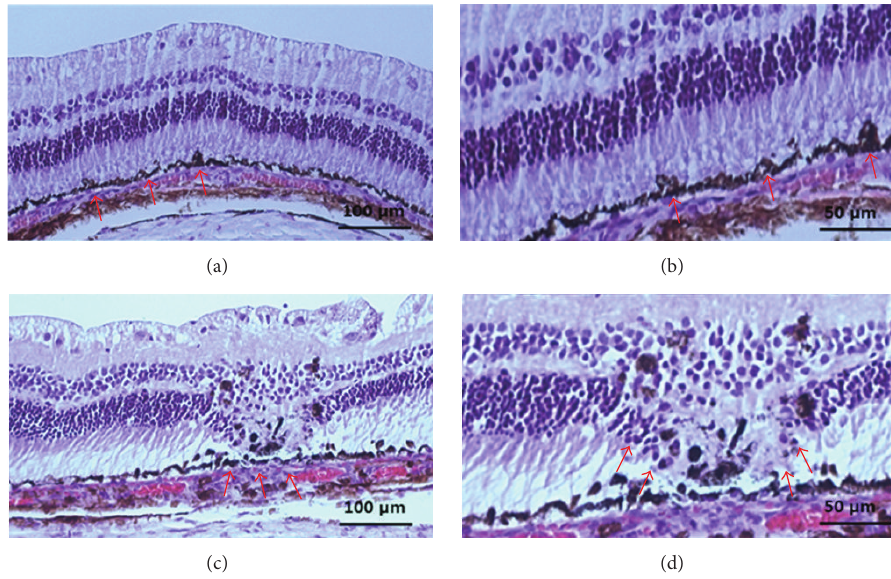
Figure 5: (a, b) The photoreceptor inner segments were preserved, and the distal ends of the photoreceptor outer segments were slightly relaxed. The RPE layer proliferated focally along the SRT lesion, and Bruch’s membrane was intact. Histology of conventional laser lesions after 3 weeks. (c, d) The full-thickness structure of the retina involving the photoreceptors was disrupted and disorganized (magnification 200x; a, c) (magnification 400x; b, d) (red arrow, irradiated